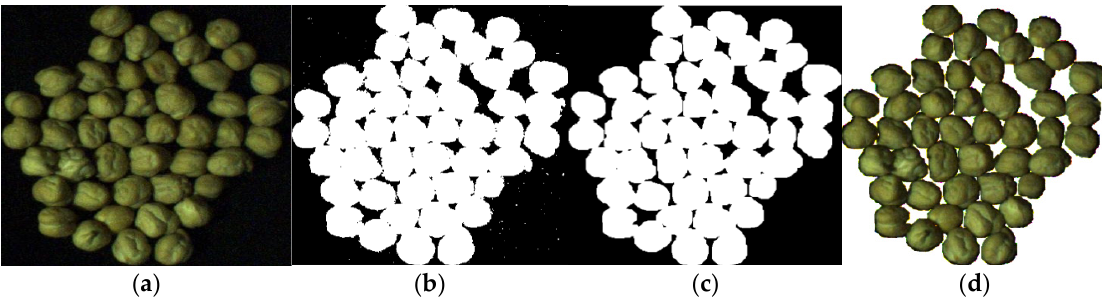
Figure 2. Different stages of the segmentation process. ( a ) input image; ( b ) binary image after application of equation (1); ( c ) result of morphology operator open; ( d ) resulting segmented image.